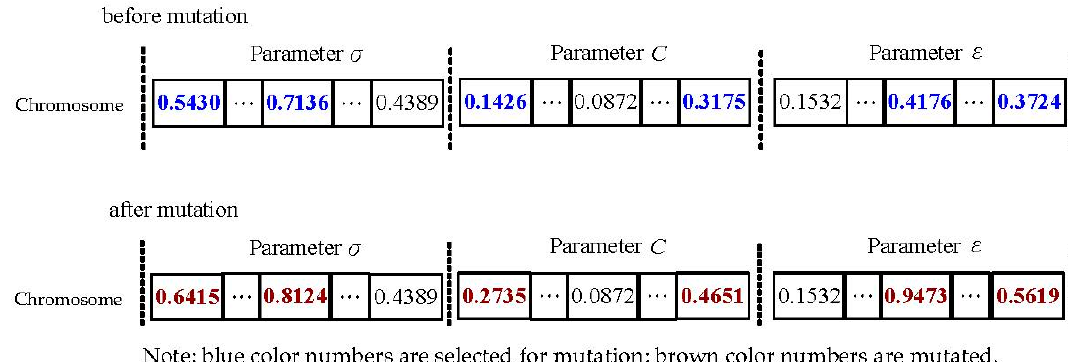
Figure 4. Example of the chromosome form of the parameter for the quantum mutation operation.